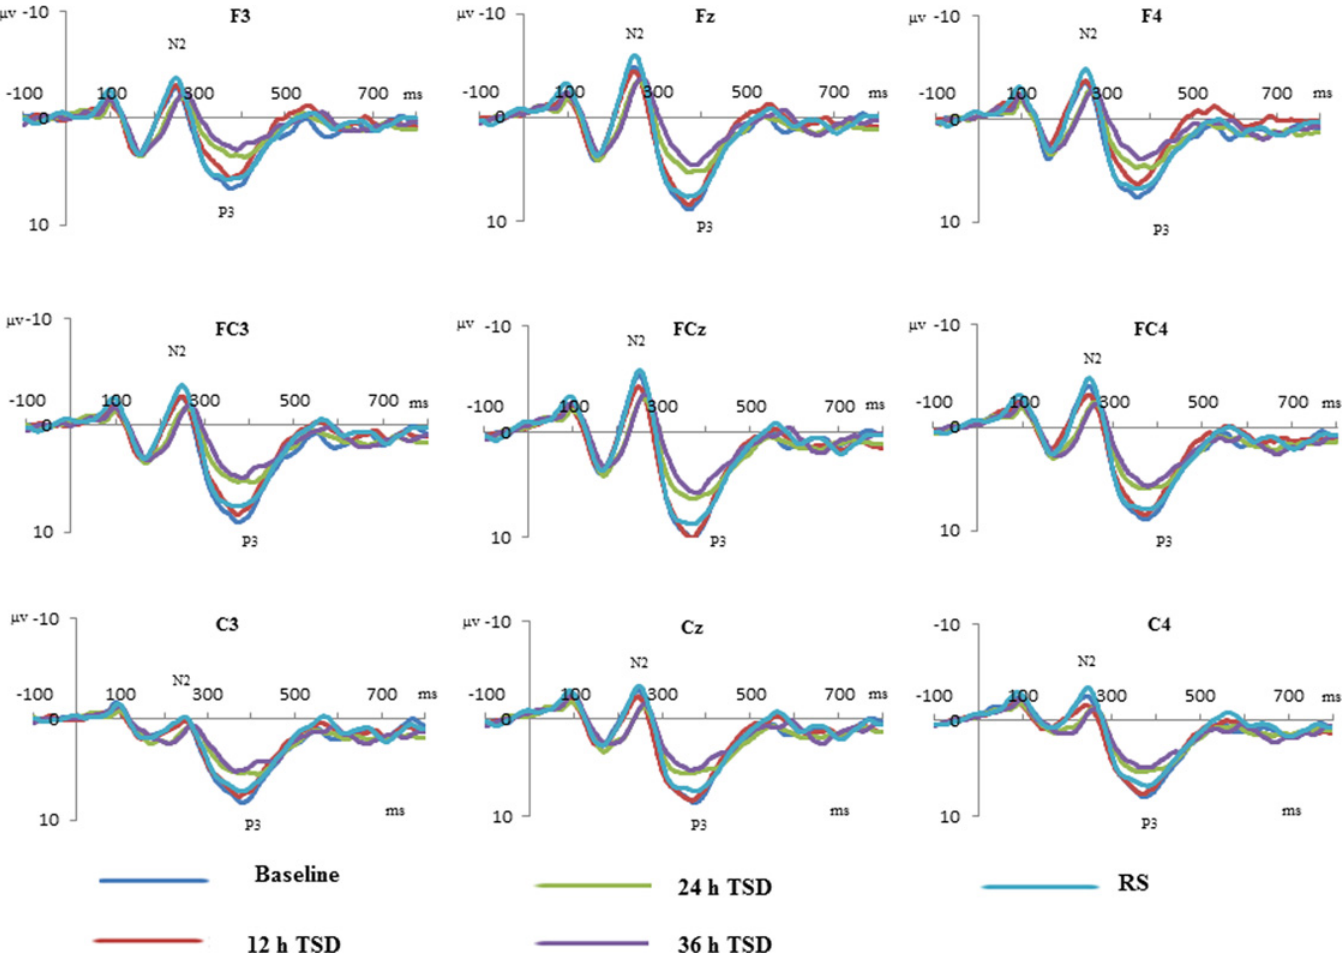
Fig 3. Grand-average event-related potential waveforms at F3, FC3, C3, Fz, FCz, Cz, F4, FC4, and C4 for NoGo trials in different time points. The color waveforms represents respectively the baseline, after 12-h of total sleep deprivation (TSD), after 24-h of TSD, after 36-h of TSD and after 8-h recovery sleep.